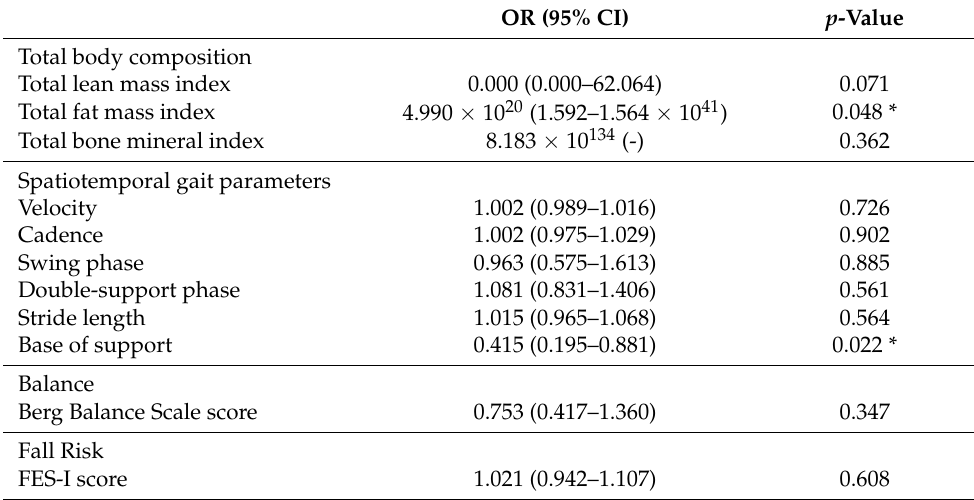
Table 2. Regression analysis and odds ratio (OR) of each body composition and gait parameter.